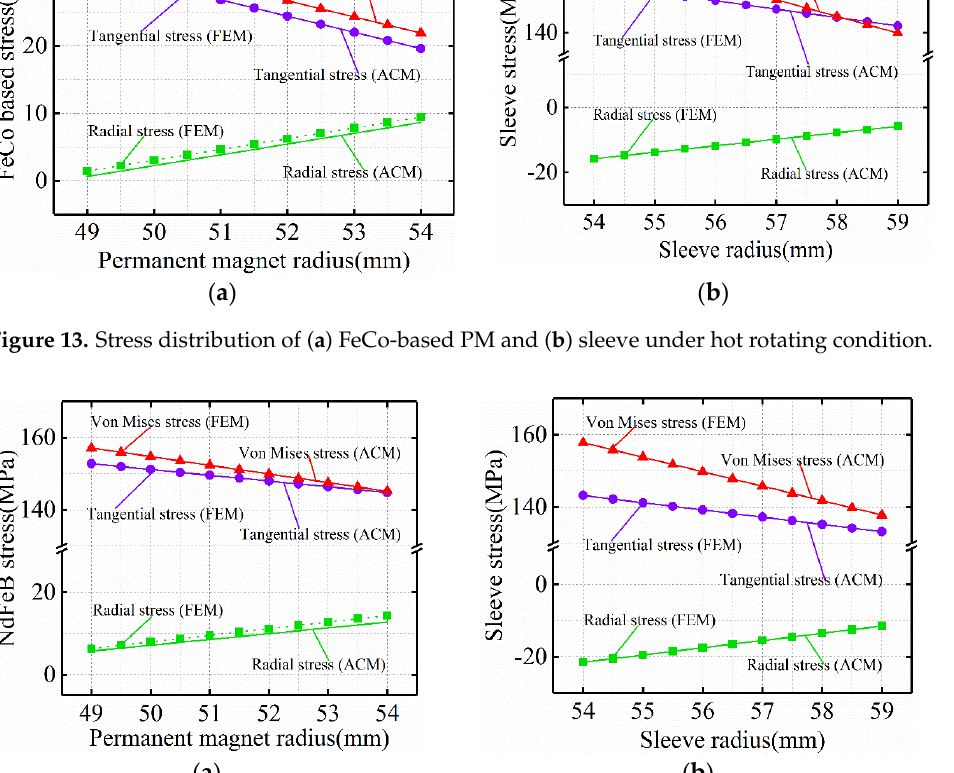
Under hot rotating condition, because the TEC of carbon steel rotating shaft is greater than